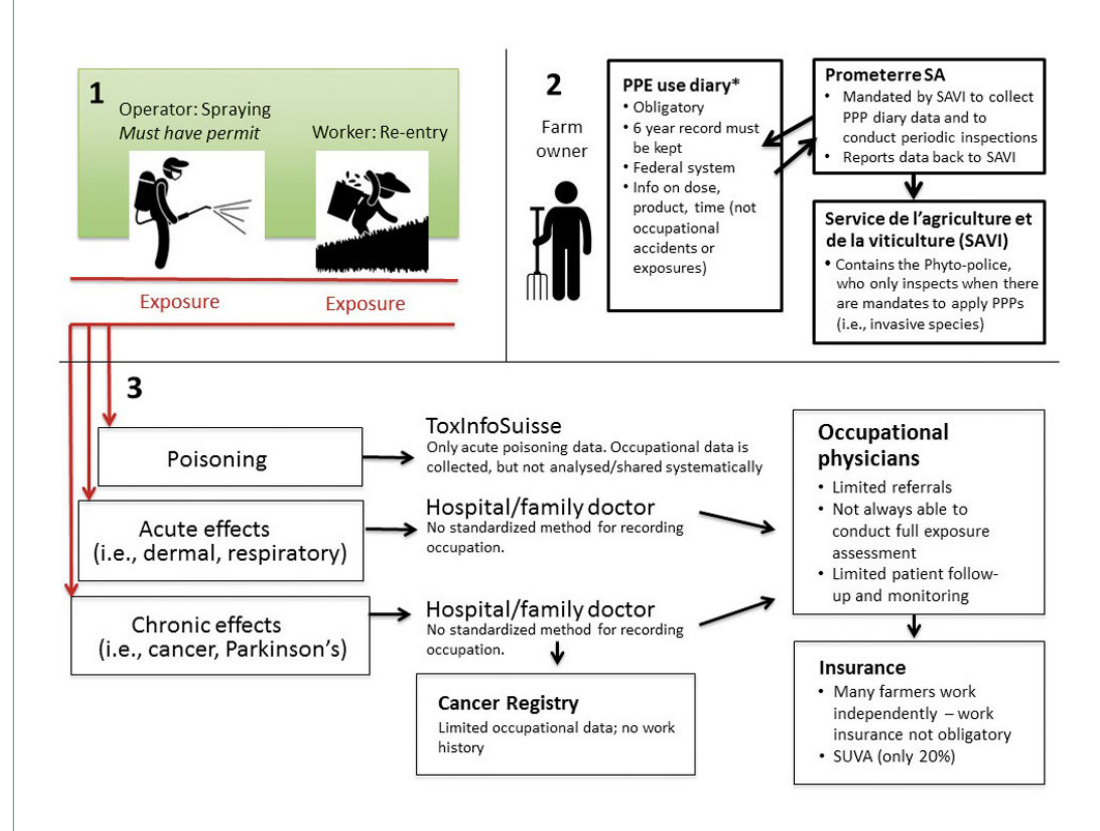
Figure 2: Information flow diagram of the generalised process of occupational PPP exposures and resulting health effects. Part 1 demon- strates occupational exposure scenarios; part 2 describes the reporting of PPP use; and part 3 traces the reporting pathway of different health effects, from clinical assessment to insurance claims. *Translated from French ( Journal d’exploitation ;